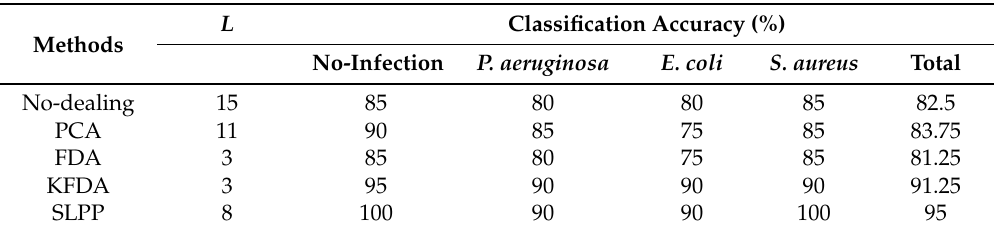
Table 7. Classification results of 10-fold using different data processing methods (KNN).